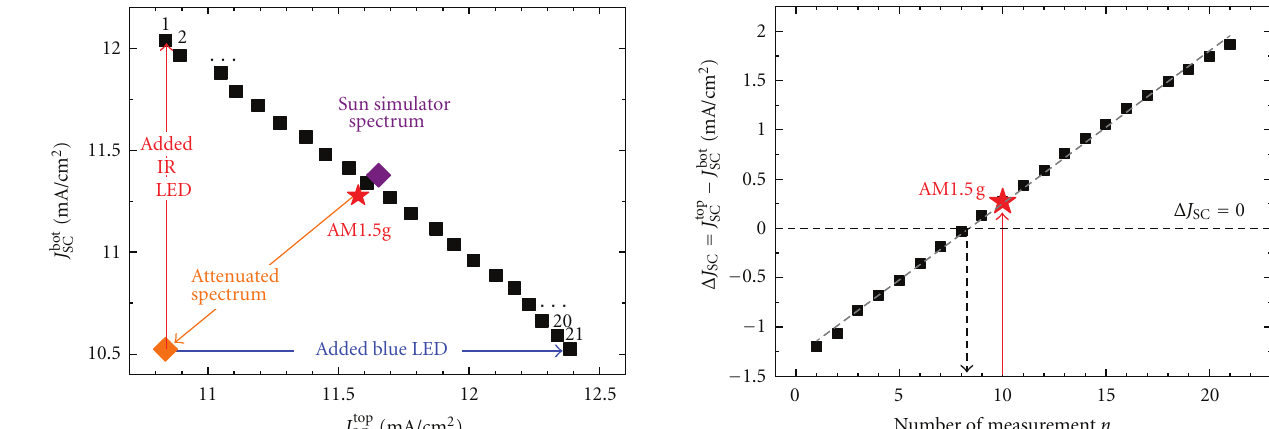
F 4: e measured external quantum efficiency of the refer- ence cell and the illumination spectra are used to calculate the short- circuit current densities the current densities for the AM1.5g standard spectrum (red star) and for the sun simulator spectrum (violet diamond) are given along with the value for the attenuated sun simulator spectrum (orange diamond). e stepwise changed LED illumination (measurements number 1 to 21) leads to, respectively, increased top and decreased bottom cell current densities (black squares).